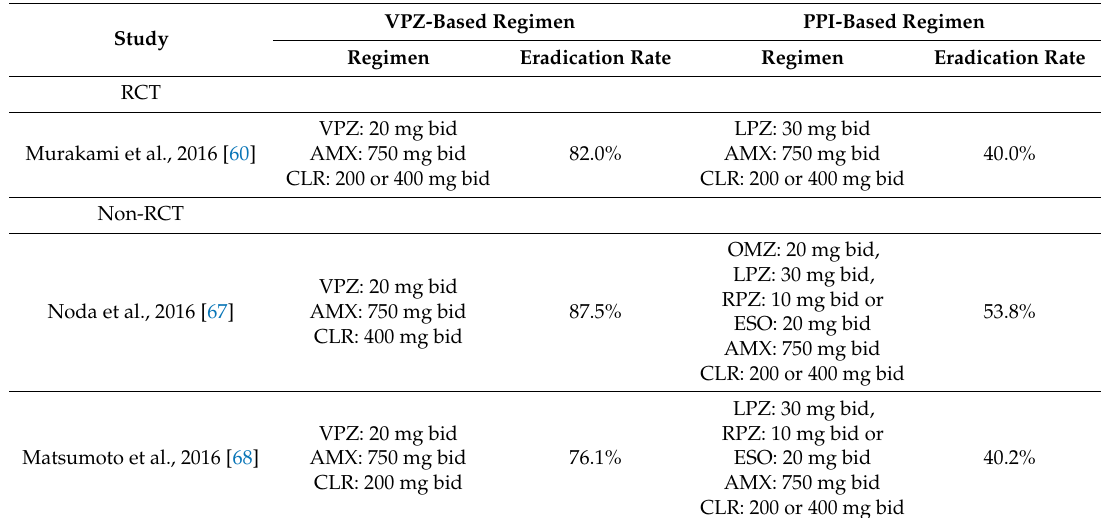
Table 4. Review of comparative studies of first-line clarithromycin-resistant H. pylori eradication